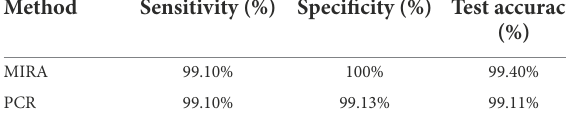
TABLE 4 Clinical efficacy testing by MIRA and PCR.